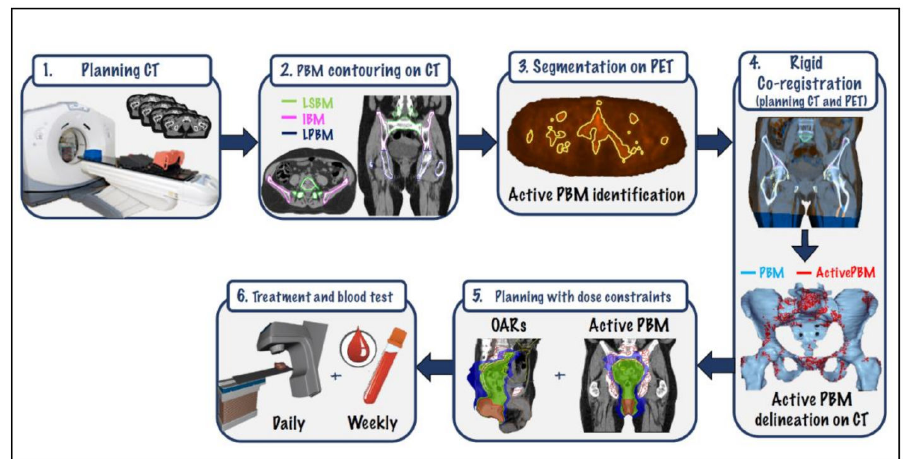
Figure 3. Comprehensive workflow for BM-sparing IMRT. CT: computed tomography; PBM: pelvic bone marrow; LSBM: lumbar-sacral bone marrow; IBM; iliac bone marrow; LPBM: lower-pelvic bone marrow; PET: positron-emission tomography; OARs: organs at risk.